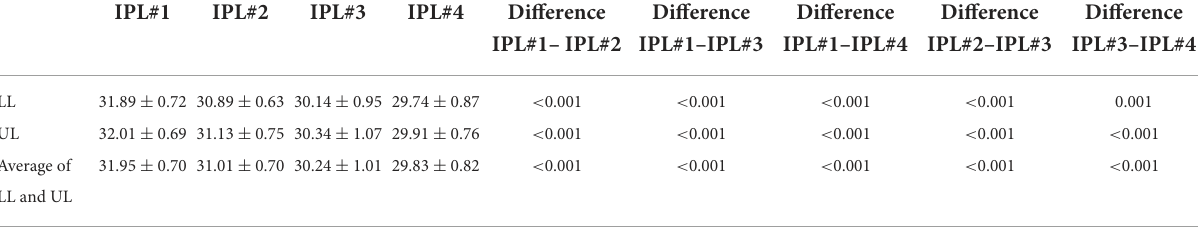
TABLE 1 Changes in the skin temperature ( ◦ C) of eyelids after each intense pulsed light treatment.